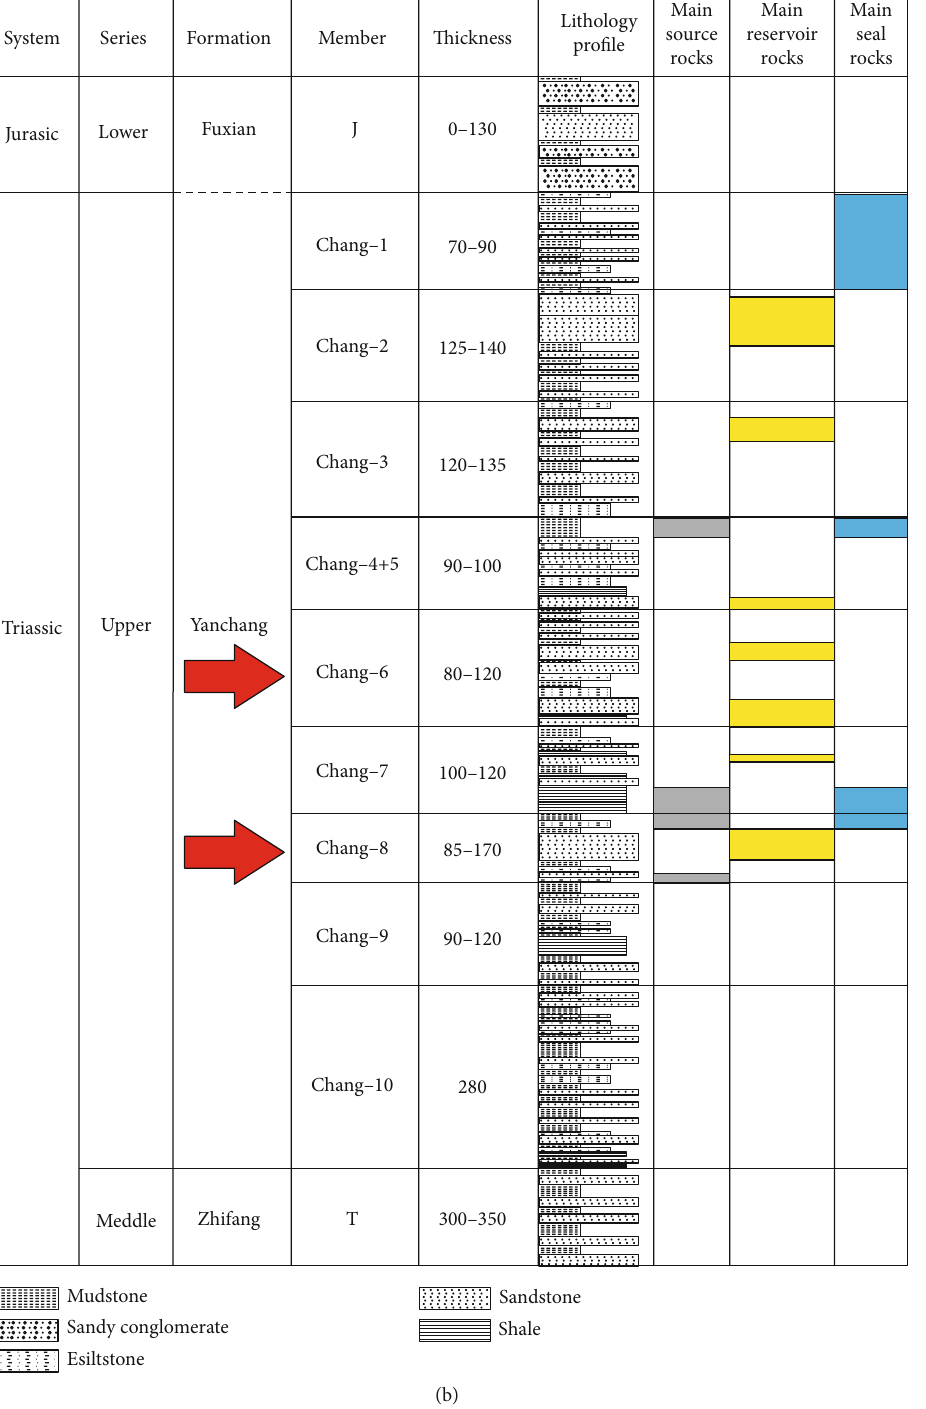
Figure 1: (a) Location of the Ordos Basin concerning fi rst-class tectonic elements of the Ordos Basin. (b) Stratigraphic column from Upper Triassic Yanchang Formation in Ordos